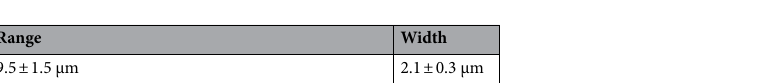
Figure 7. Depth ( A ) and lateral ( B ) profiles of alpha-particle trajectory for HE alpha source.